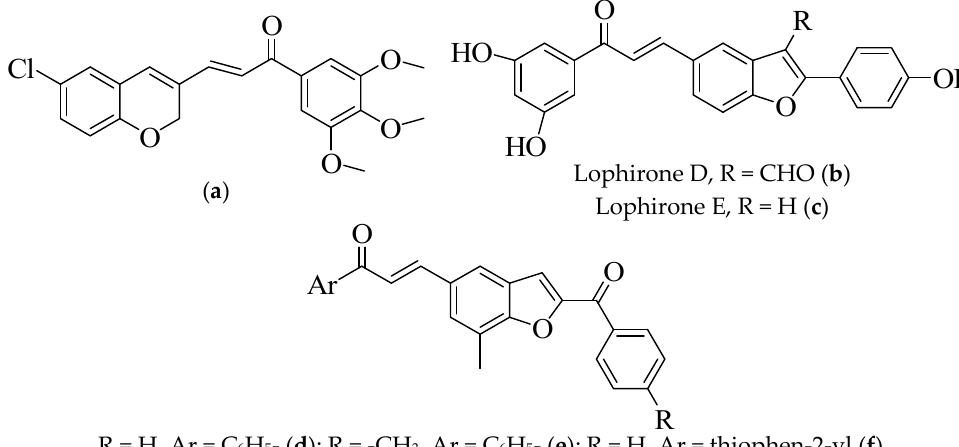
Figure 1. Compound ( a ) and examples of biologically relevant linear benzofuran-chalcone